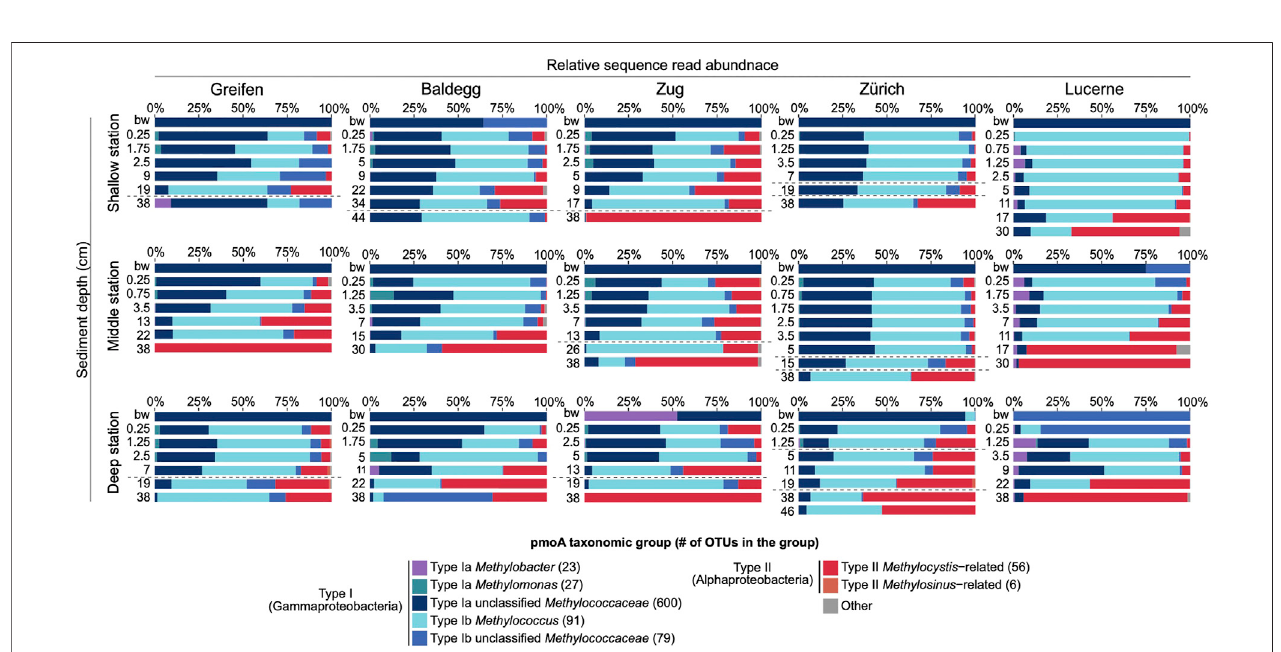
FIGURE 5 | Barcharts showing depth distributions of dominant genus-level pmo A taxa/clades across lakes and stations ( x -axis: percentage of total pmo A reads persample; y -axis:sedimentdepthincm;bw=bottomwater).OTUsthatcouldnotbeassignedtoanyknownMOBgeneraweretermed “ Unclassi fi ed ” (TypeIa/Type Ib Unclassi fi ed Methylococcaceae). Stations are ordered from shallow (top row) to deep (bottom row). Dashed horizontal lines indicate transitions from oligotrophic to eutrophicforLakeGreifen,LakeBaldegg,LakeZug,andLakeZurich,atstationswherethedeepestrecoveredsamplesweredepositedwhentheselakeswerestill oligotrophic.AseconddashedhorizontallineinshallowerlayersofLakeZurichindicatesthetransitionfromeutrophictomesotrophicaround1980.Note:measurableO 2 concentrations( > 1 – 2 µM)wereonlypresentintheshallowestsedimentsamplefrom0.25cm,exceptattheshallowstationinLakeLucernewhereO 2 wasmeasurableat 0.25 and 0.75 cm sediment